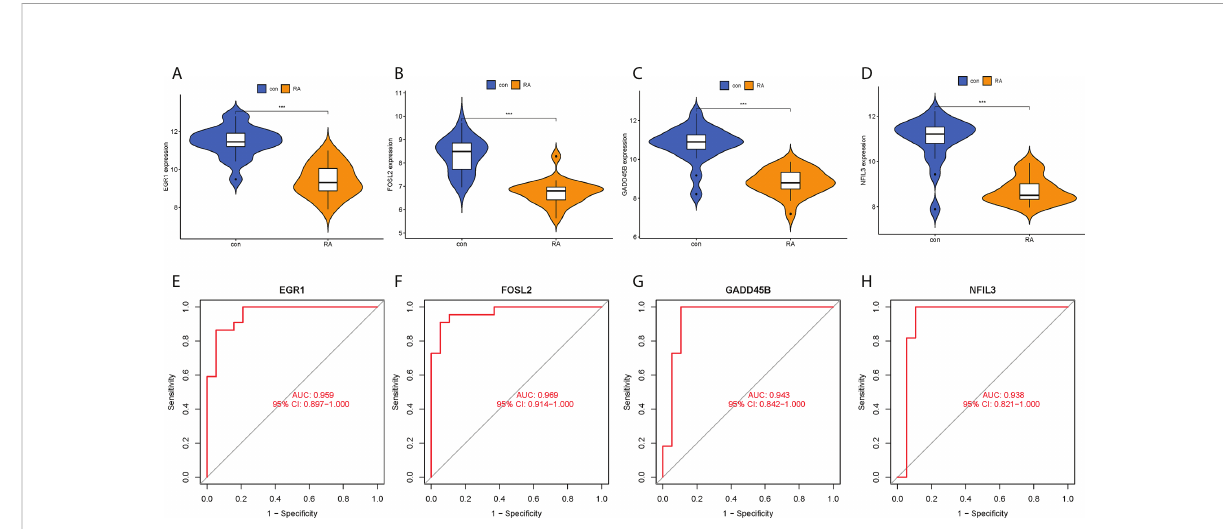
FIGURE 7 Expression levels and ROC curves of hub CRGs. (A – D) Violin plots of the difference in expression levels of hub CRGs between RA and control groups. (E – H) ROC curves manifested the diagnostic ef fi cacy of each hub gene. ***p < 0.001. AUC, area under the curve.